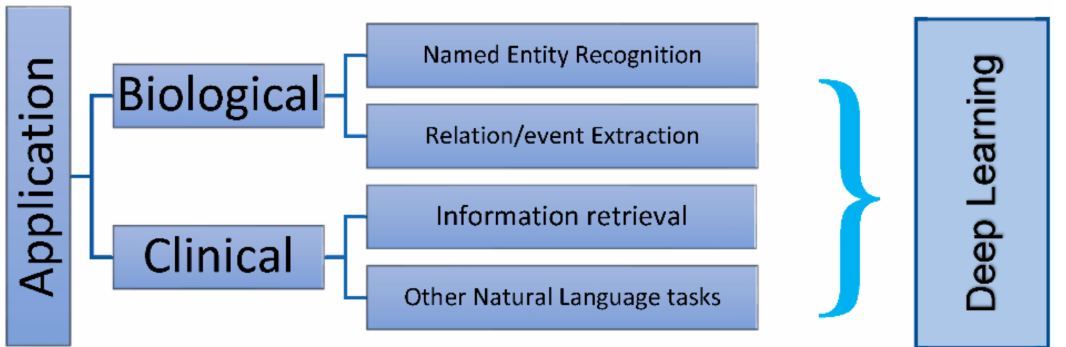
Figure 2. Application of AI in